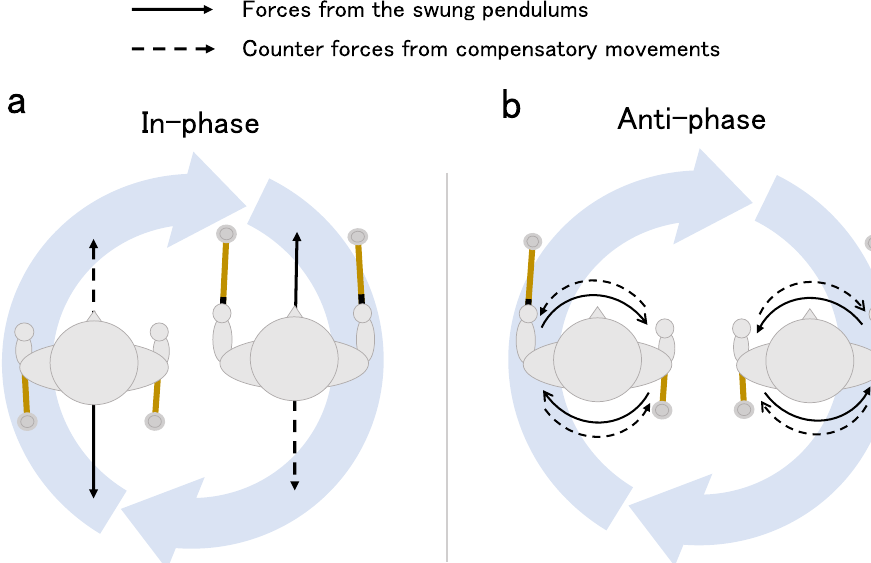
Fig 9. Schematic diagram of possible forces at work and compensatory movements during the present experiment by phase mode. Solid lines indicate the direction of forces caused by swinging the pendulums, which may affect the body, and dashed lines indicate the direction of counter forces caused by possible compensatory movements. This study’s results appear to correspond to the compensatory movements shown in this diagram.